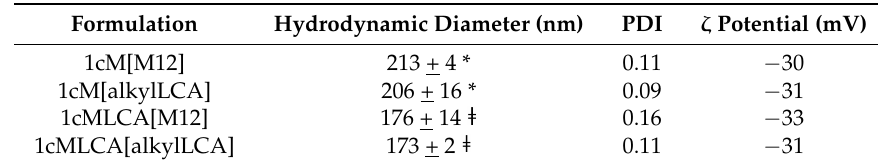
Table 1. Physicochemical properties of AScM NPs indicating particle size, polydispersity index (PDI) and ζ potential determined by dynamic light scattering measurements. Formulation notation is denoted as Shell[Core], and statistical differences are indicated by different